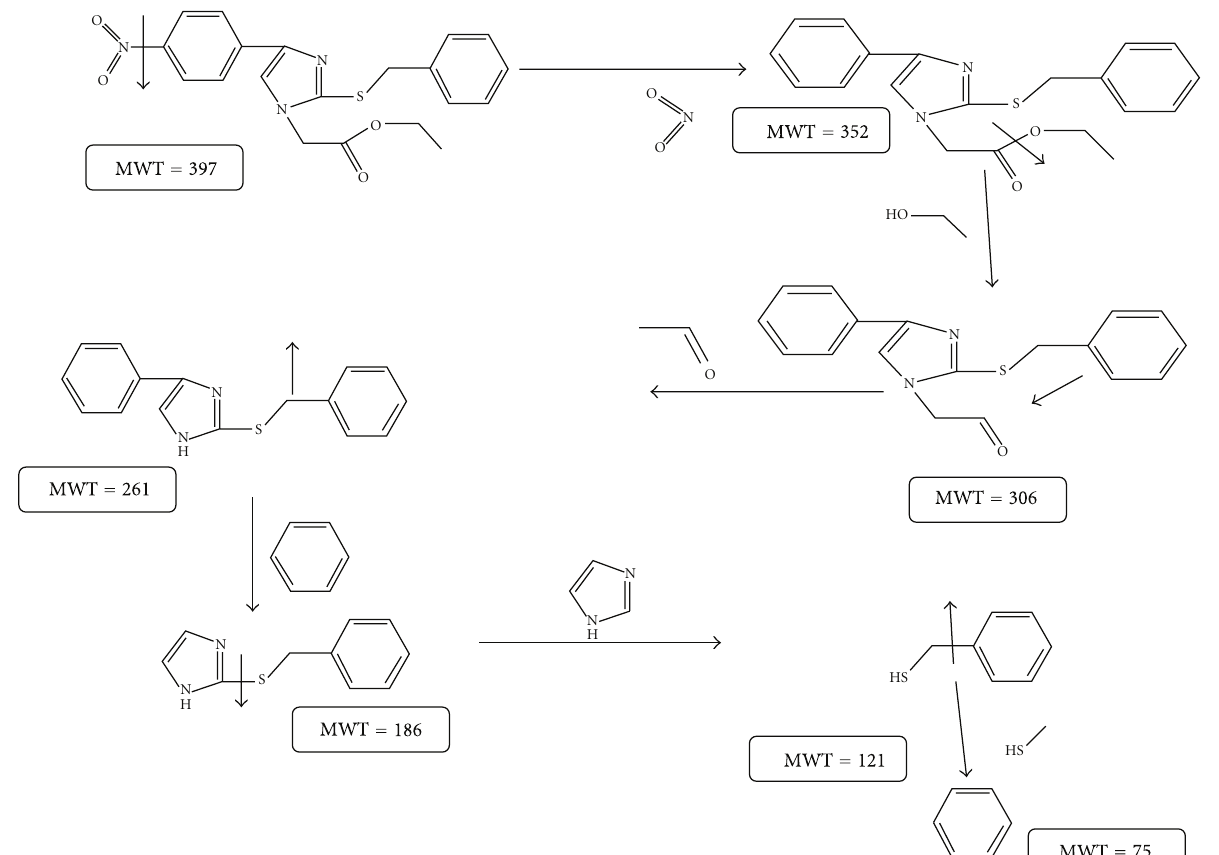
Figure 3: MS fragmentation pattern of active ingredient separated from ethyl acetate fraction of E.